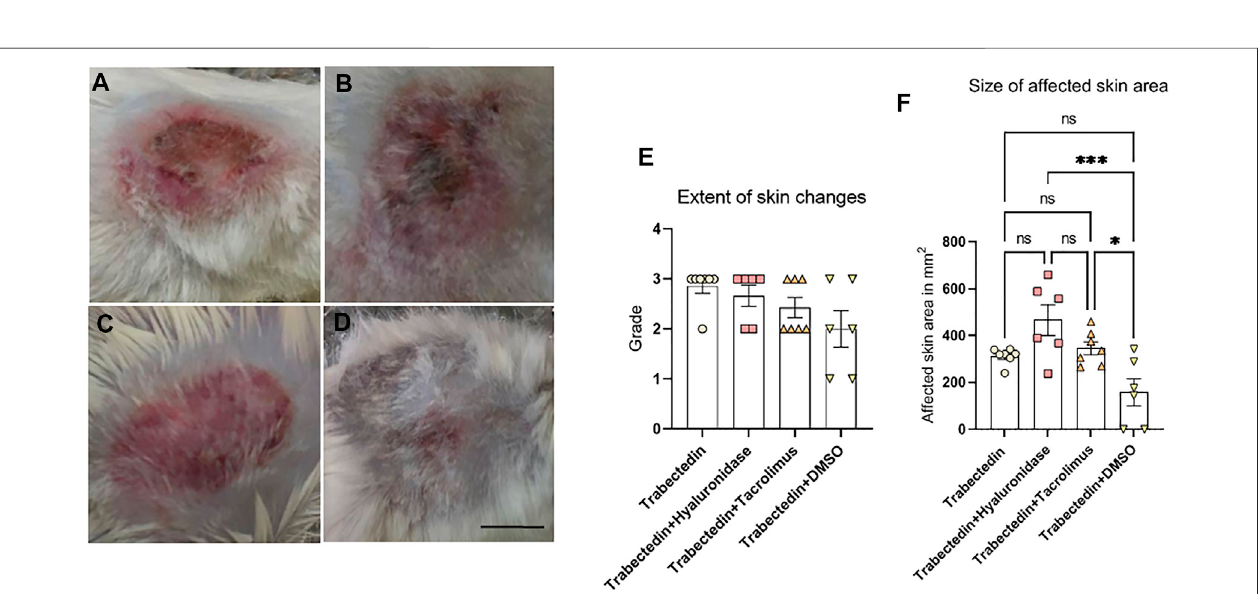
Frontiers in Pharmacology |